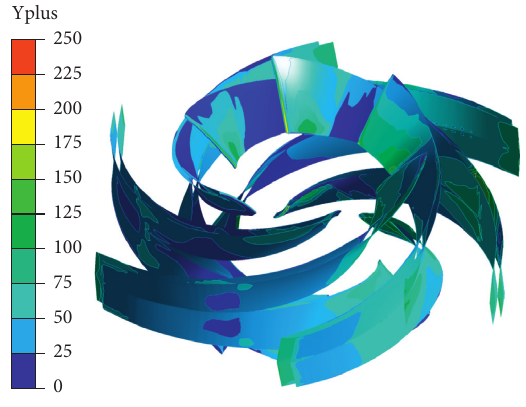
Figure 4: Blade surface Y +